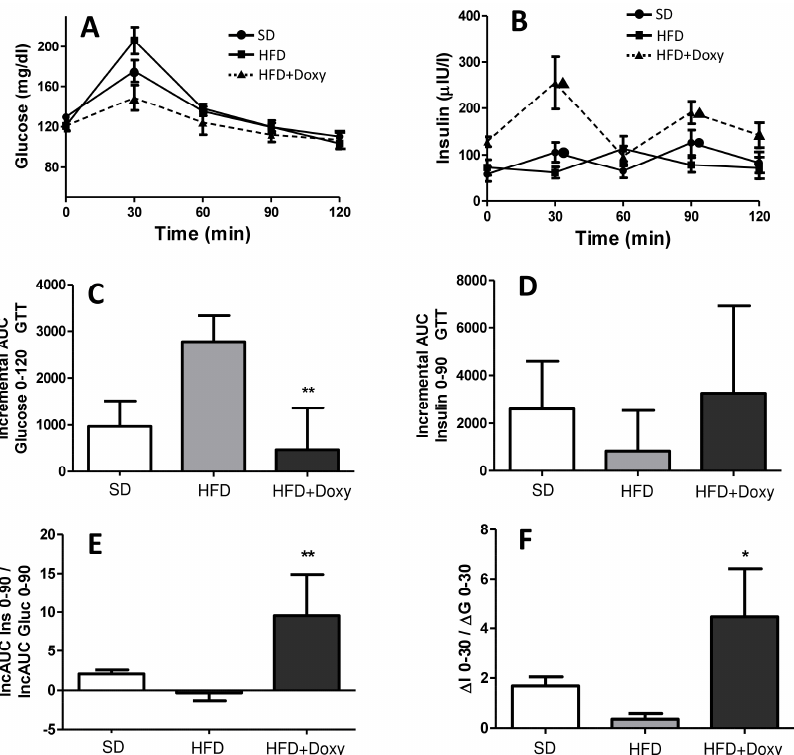
Figure 2. Serum glucose and insulin values in a glucose tolerance test (GTT). Data are shown as mean ± SD. ANOVA analyses show intergroup differences in ( A – C , F ) ( p < 0.05 for all analyses). Changes in the mean blood glucose ( A ) and insulin ( B ) concentrations over 120 min. HFD + Doxy group at 30 min had a significantly lower glucose level compared with SD ( p = 0.010) and HFD groups ( p = 0.008). Additionally, the HFD group presented a significantly higher glucose value compared with the SD group at the same time point ( p < 0.001). Meanwhile in the insulin comparison at 30 min, the HFD + Doxy group exhibits a significantly higher level when compared with the SD ( p = 0.013) and HFD groups ( p = 0.002), while the HFD and SD groups did not show differences. The incremental area under curve (gAUC) of the glucose measurements ( C ) show that the HFD + Doxy group had lower values that the HFD group ( p < 0.001), but with similar values to that of the SD group ( p = 0.520). The incremental area under curve (iAUC) of the insulin measurements ( D) shows no statistical difference between the groups. After adjusting insulin secretion for the incremental AUC of glucose ( E : iAUC/gAUC 0–90min ratio), elevated values are clearly shown in the HFD + Doxy group, compared to HFD (** p = 0.013), but similar values are seen when compared with the SD group ( p = 0.147). **Indicates statistically significant difference between HFD+Doxy and SD group. The β cell function index ( F , ratio ∆ Insulin0–30/ ∆ Glucose0–30) indicates that the group with doxycycline had a better secretory function of the beta cell than the HFD and SD groups ( p = 0.001, and p = 0.010, respectively). *Indicates statistically significant difference between HFD+Doxy and the rest of the groups (SD and HFD).